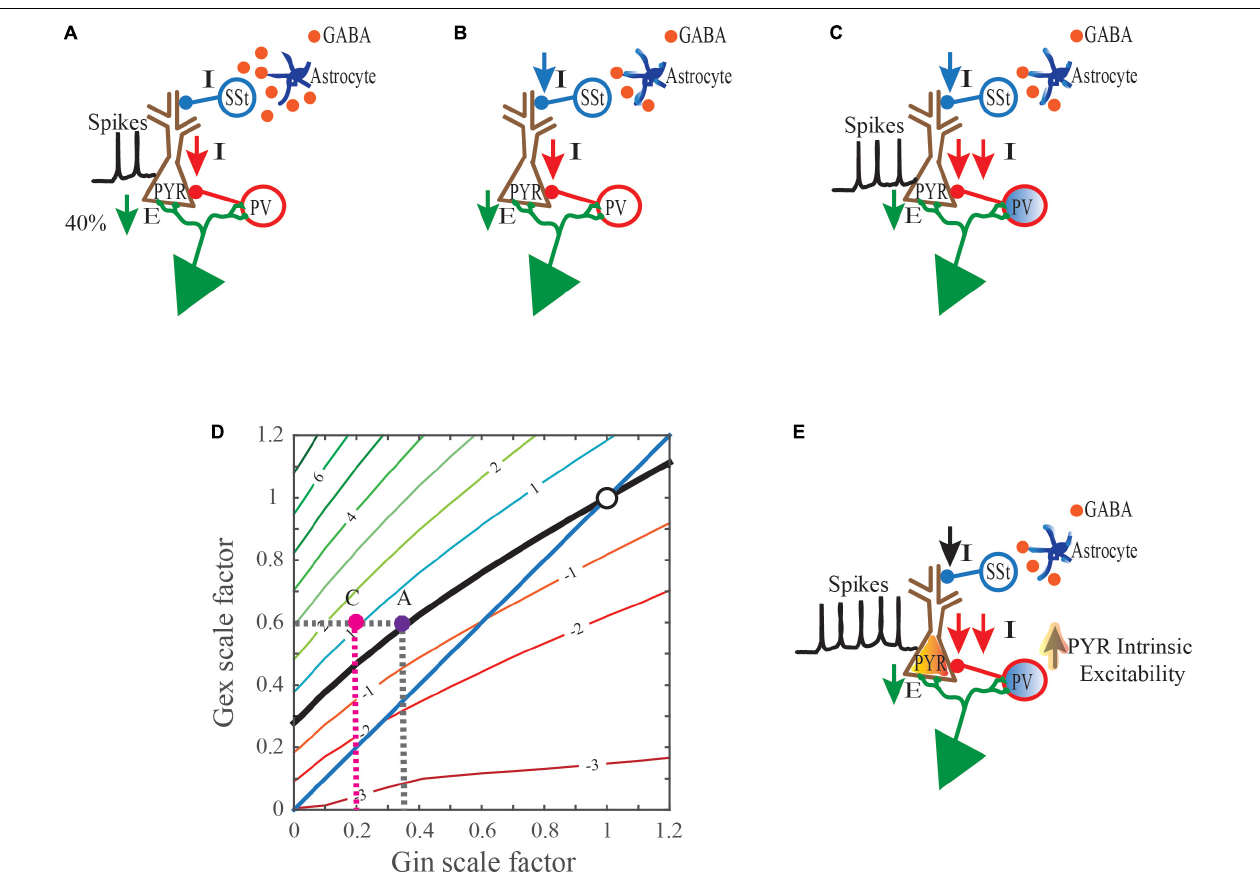
FIGURE 2 | Collective mechanisms that may drive hyperexcitability when synaptic excitation levels are reduced. (A) A gene mutation that is linked to a neurodevelopmental disorder (NDD) induces cell autonomous changes in glutamatergic PYR neurons that reduce their excitatory postsynaptic input (E). This primary defect in the PYR neurons triggers cell autonomous decreases in inhibitory postsynaptic inputs (I). (B) The same NDD-linked gene mutation also induces cell autonomous changes in astrocytes that may reduce ambient GABA levels in the extracellular space. Reduced GABA levels may consequently lessen inhibitory output in select subsets of interneurons. In this example, somatostatin-positive (SSt + ) neuron-mediated inhibition is reduced. (C) This NDD-linked gene mutation can also induce cell autonomous changes in parvalbumin-positive (PV+) interneurons which impair their inhibitory output. Moreover, these inefficiencies are perhaps exacerbated during incidences of strong or sustained inputs, as the ability of PV neurons to scale-up their responses is compromised. (D) In response to the 40% reduction in excitatory postsynaptic input from (A) , even less inhibition is now provided due to the combined effects of cell autonomous changes in astrocytes and PV+ interneurons. i.e. in C ( • pink dot) an 80% drop, instead of the expected 65% that would typically occur in (A) ( • purple dot). The net effect is PSPs that are 1mV larger than normal and increased depolarization levels ( • pink dot). (E) Events in (D) help drive an increase in the intrinsic excitability of PYR